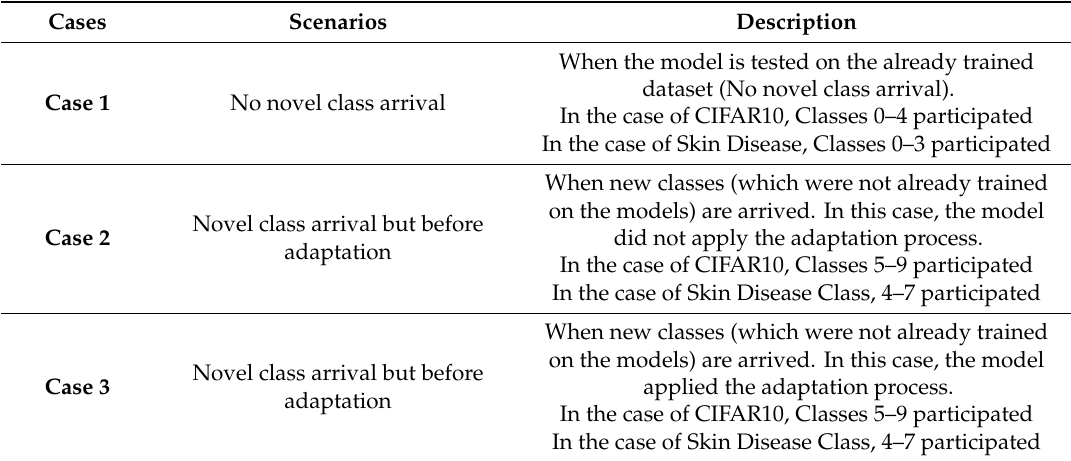
Table 3. Cases, scenarios and their description.